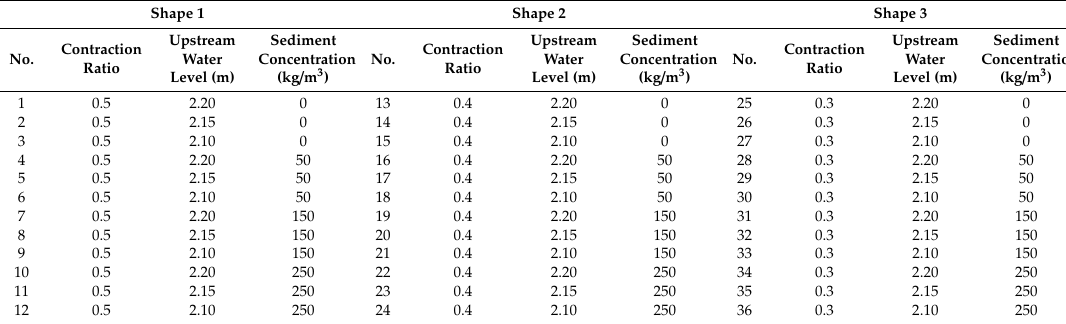
Table 1. Experimental